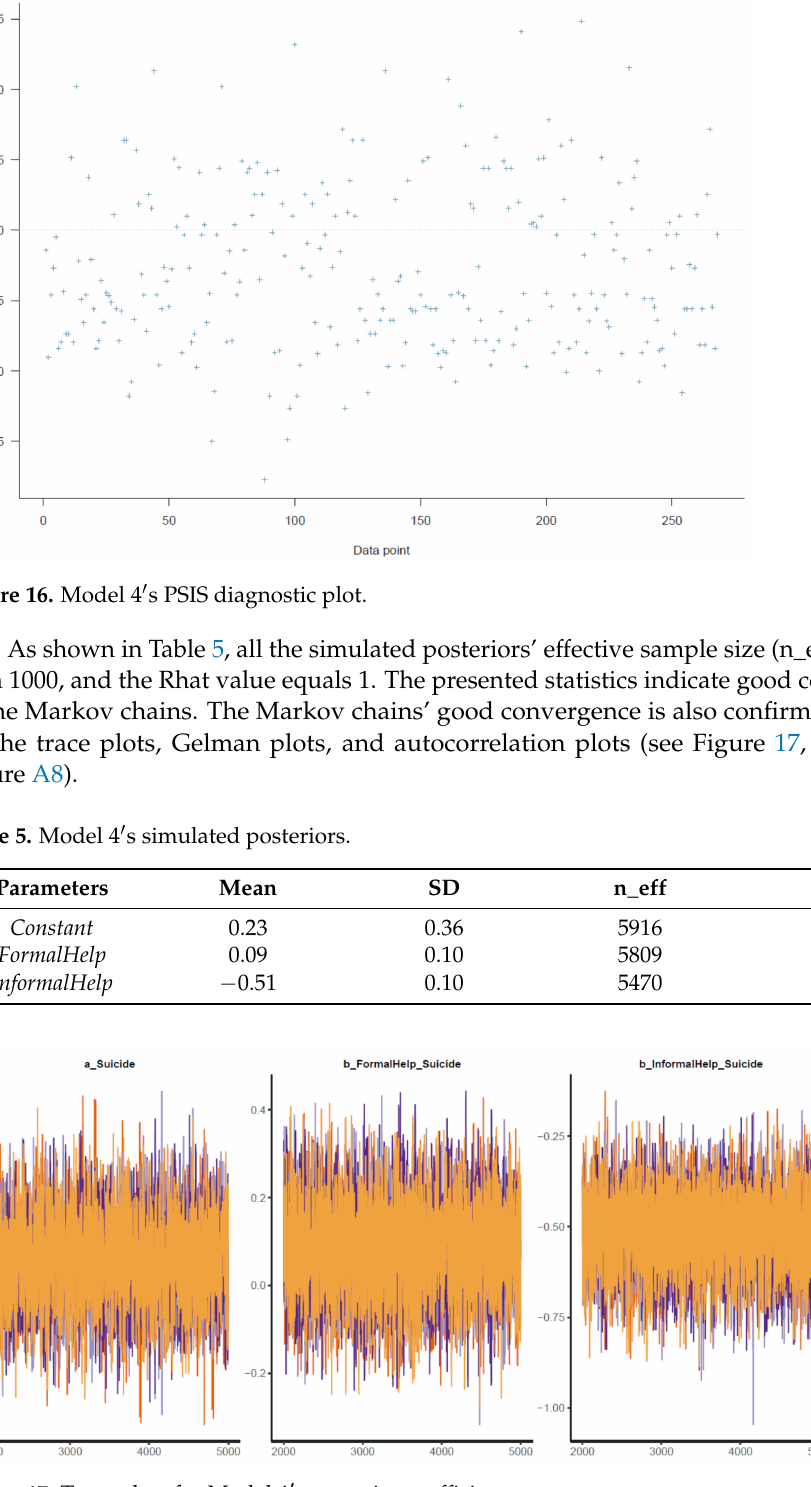
Figure 17. Trace plots for Model 4 (cid:48) s posterior